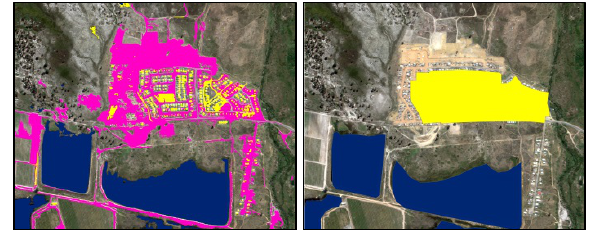
Figure 6. Left: Classification, right: topographic data (2010). Bare (pink), built-up (yellow), water (blue) ©WorldView-2 Image Copyright 2014, DigitalGlobe.